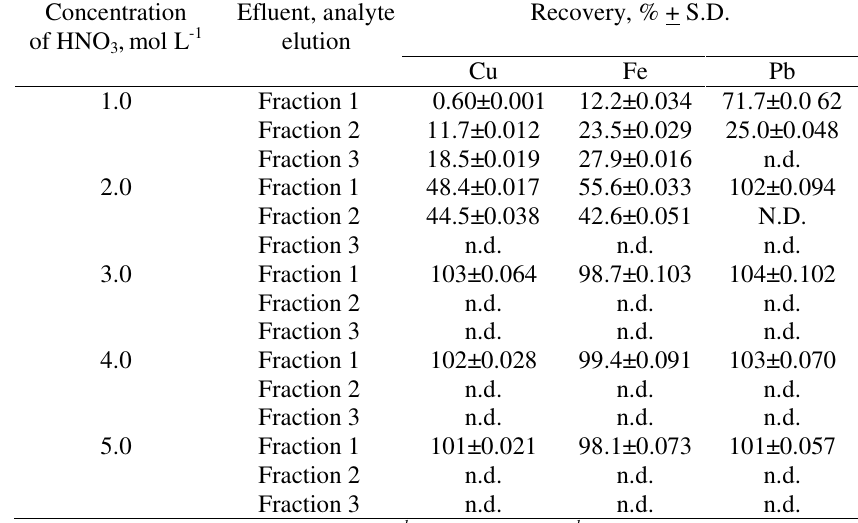
Figure 4. Effect of DDTC concentration on the recovery of 5 mg L -1 Fe and 2.5 mg L -1 of Cu and Pb ( n = 6) Table 1. Recovery of Cu, Fe and Pb determination in each fraction (10 mL) of the analyte elution ( n =